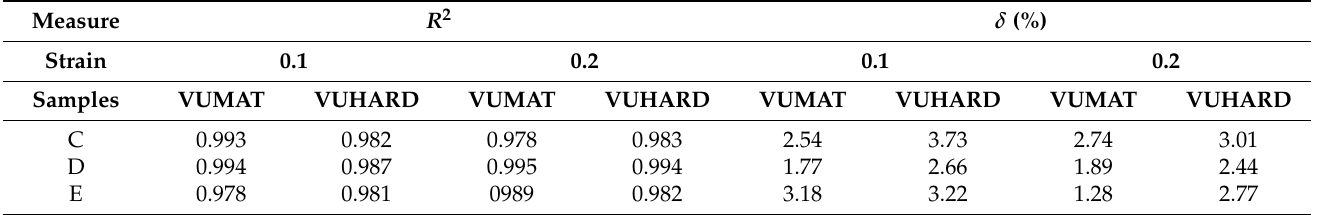
Table 5. Absolute percentage error ( δ ) and correlation coefficient ( R 2 ) between the experimental and numerical model values of flow stress for various forms of DMLS